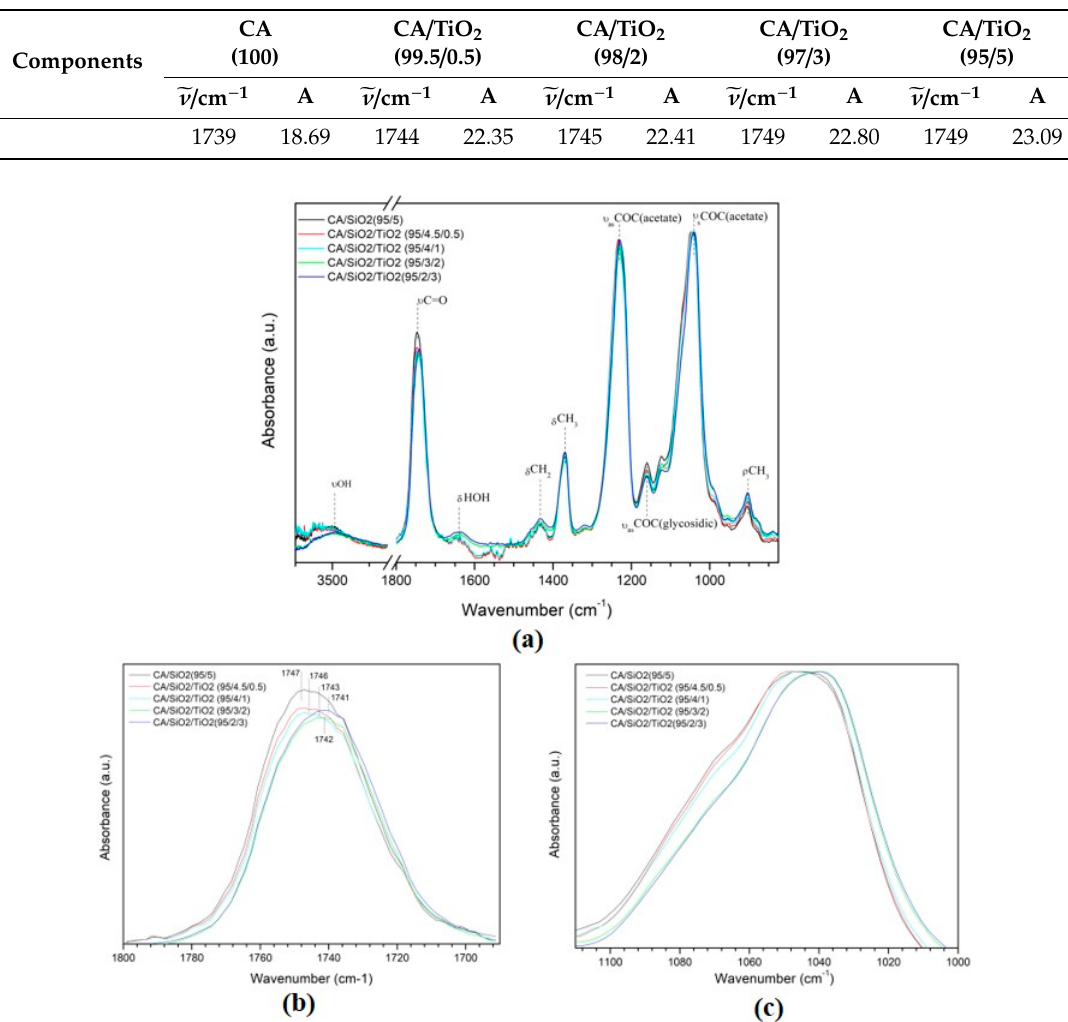
Figure 7. ATR-FTIR spectra of the reference pristine CA membrane and the hybrid CA/TiO 2 from series 2 (normalized to the C = O stretching band), ( a ) wide spectrum (4000–800 cm − 1 ); ( b ) enhanced membranes from series 2 (normalized to the C=O stretching band), ( a ) wide spectrum (4000–800 1690–1800 cm − 1 region and ( c ) enhanced 1000 and 1110 cm − 1 cm − 1 ); ( b ) enhanced 1690–1800 cm − 1 region and ( c ) enhanced 1000 and 1110 cm − 1 region.